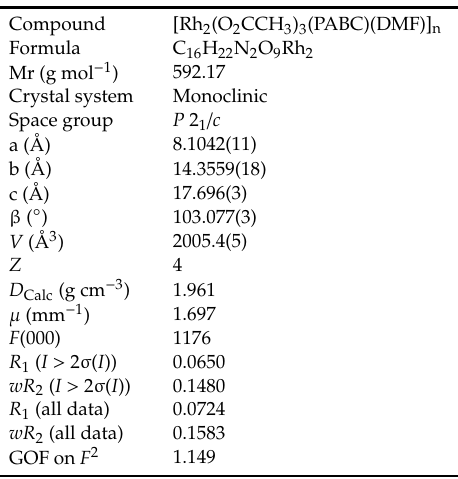
Table 1. Crystallographic and refinement data of 1P